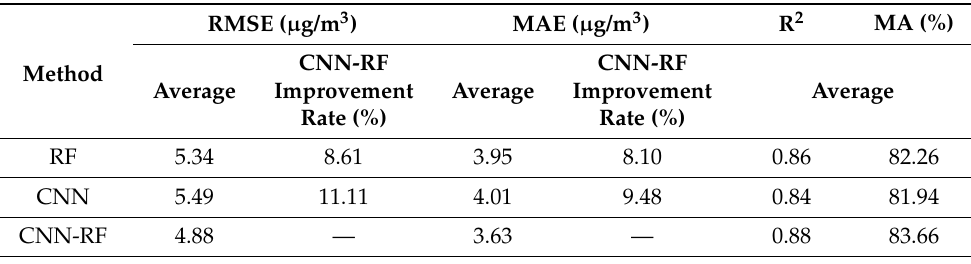
Table 5. Model comparison with average indicators at two testing